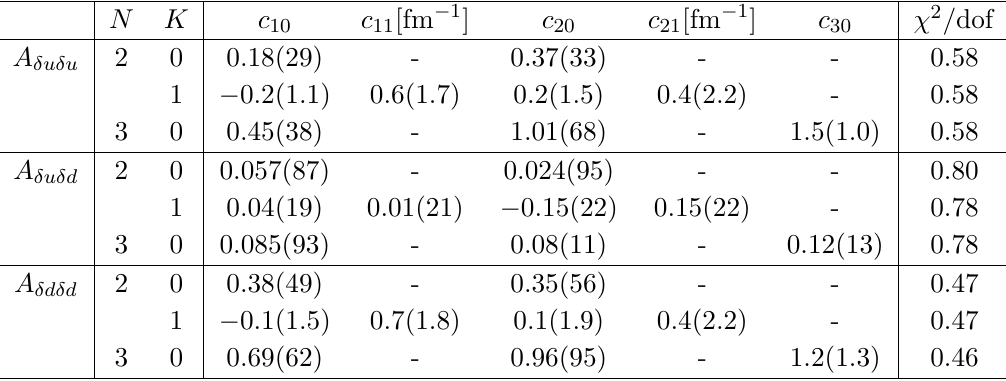
Table 10 . The same as table 7, but for the twist-two function A δqδq 0